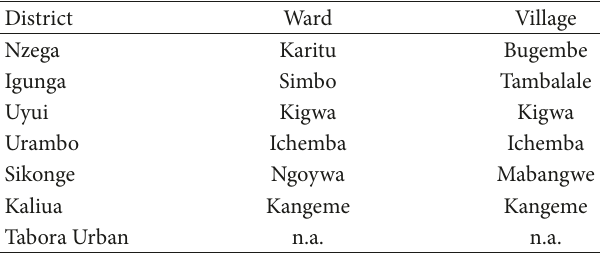
Table 1: Distribution of study villages in Tabora Region.